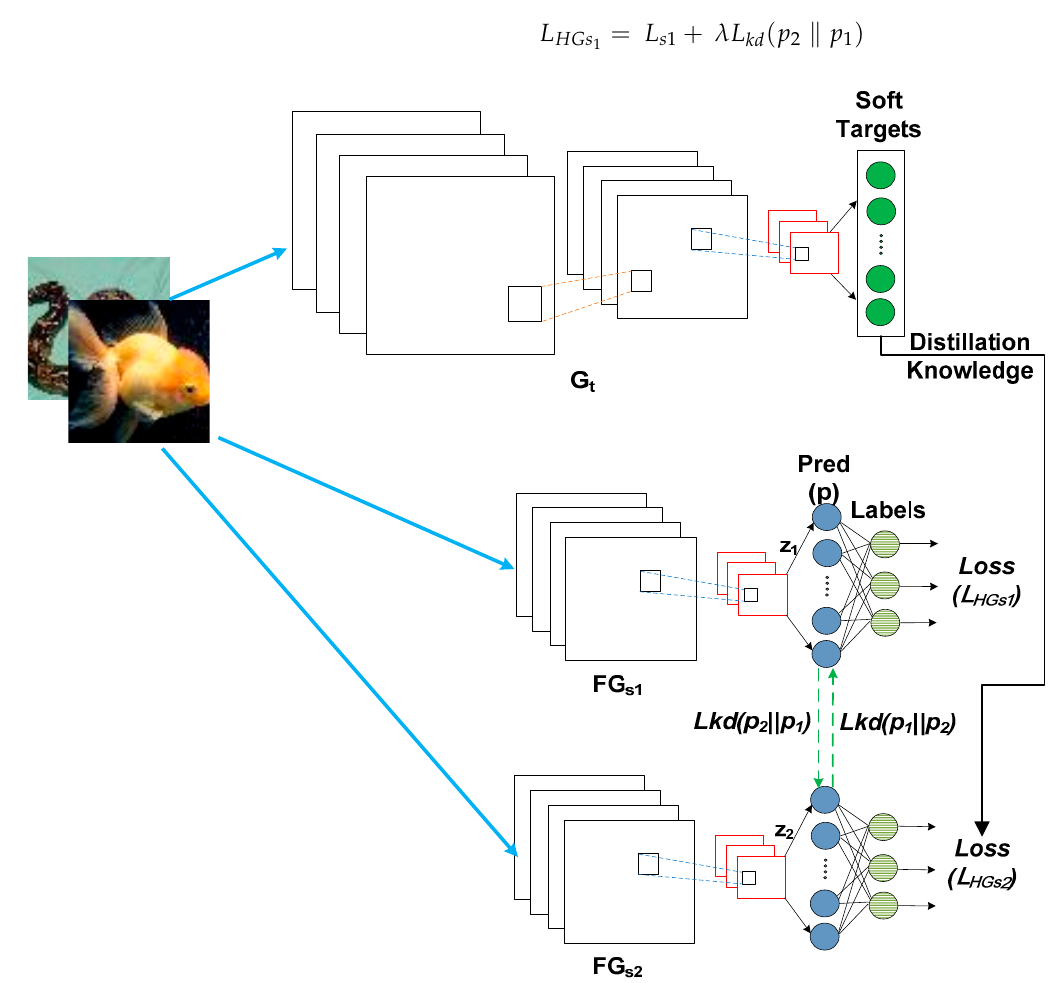
Figure 4. Half deep distillation mutual learning (HDDML) schematic.